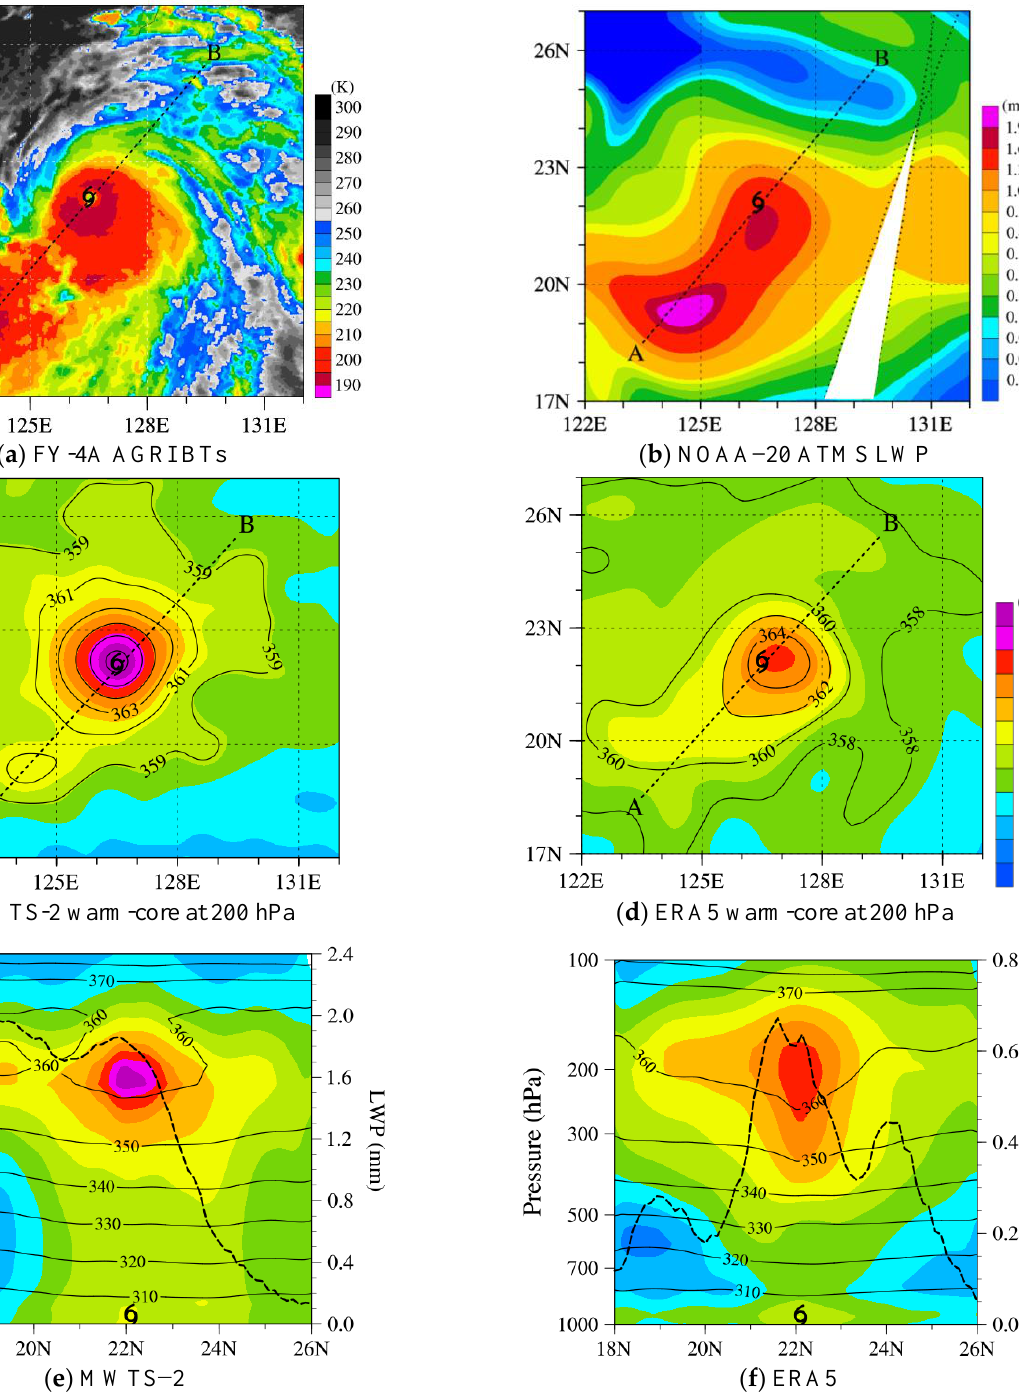
Figure 13. ( a ) FY-4A AGRI channel 12 brightness temperatures (unit: K) at 1700 UTC 7 on August 2019 and ( b ) NOAA-20 ATMS retrieved LWP (unit: mm). ( c ) FY-3D MWTS-2 retrieved and ( d ) ERA5 temperature anomalies at 200 hPa (shaded) and potential temperatures (black curves). Cross-sections of ( e ) FY-3D MWTS-2 retrieved and ( f ) ERA5 temperature anomalies and potential temperatures along the AB line, which are shown in ( c , d ), respectively.